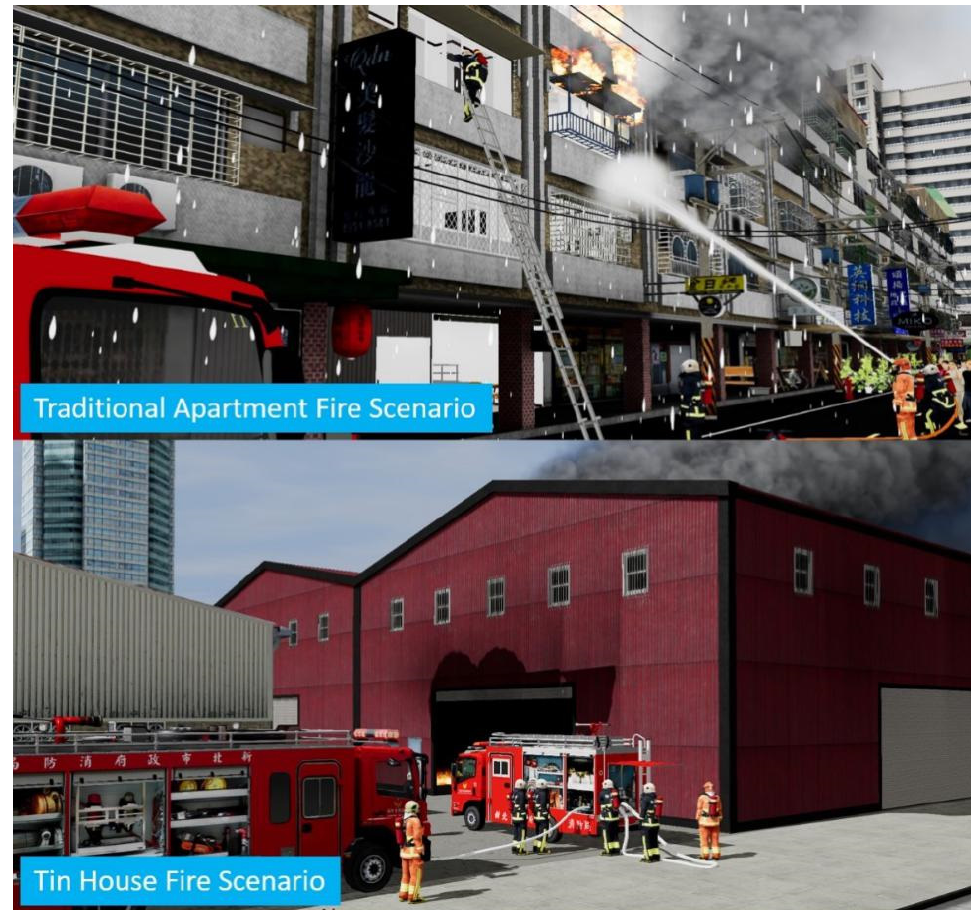
Figure 6. The two different types of buildings in this experiment’s fire simulation.